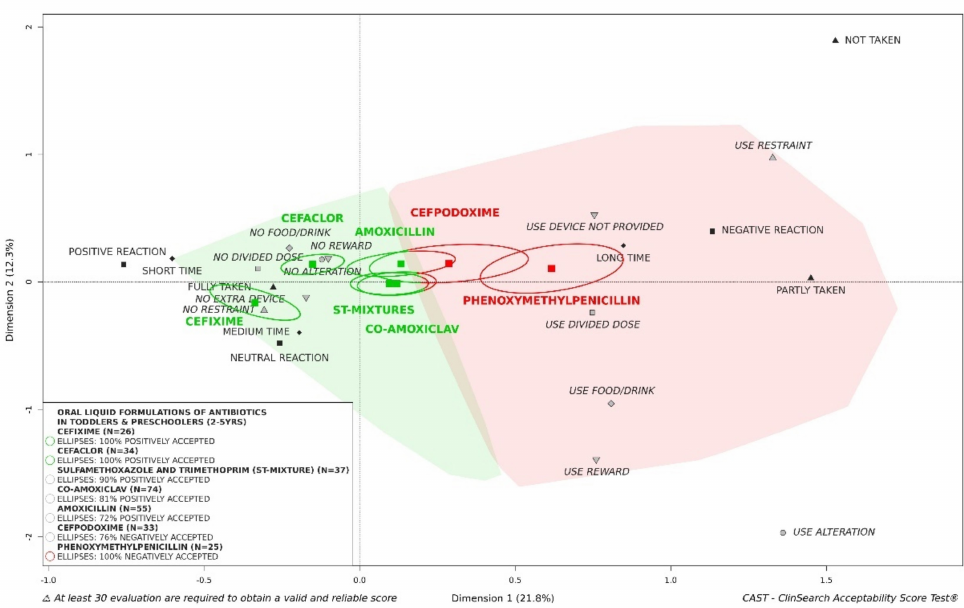
Figure 9. Acceptability of oral liquid formulations of antibiotics in toddlers and preschoolers depend- ing on active pharmaceutical ingredient